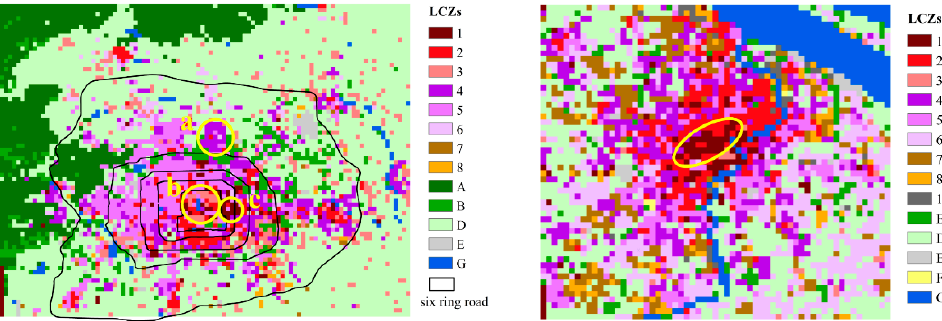
Figure 3. LCZ maps of Beijing (left) and Shanghai (right) with pixel sizes of 1 km, in